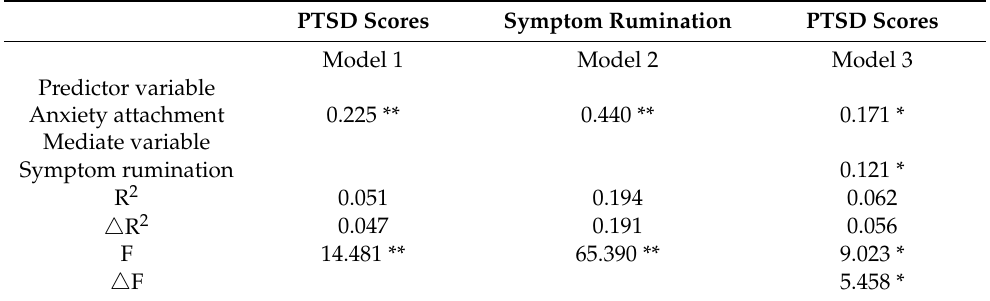
Table 2. The effect of attachment anxiety on PTSD scores: the mediating role of symptom rumination. PTSD Scores